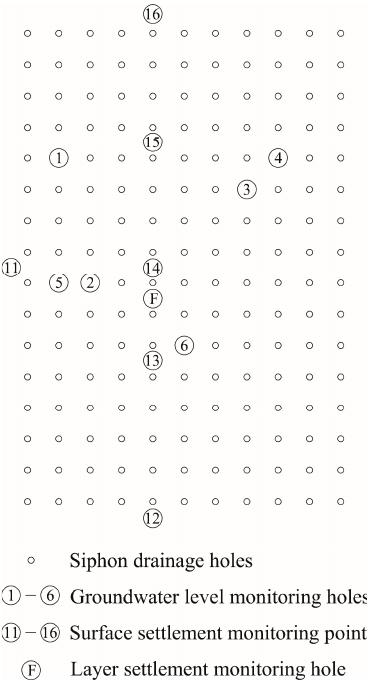
Figure 11. Layout of monitoring holes and